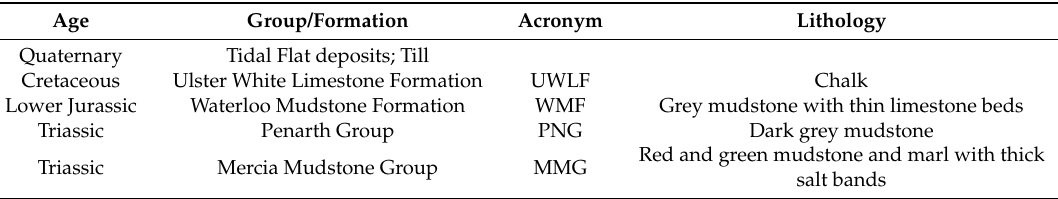
Table 1. Reference summary geology for the Carrickfergus mines